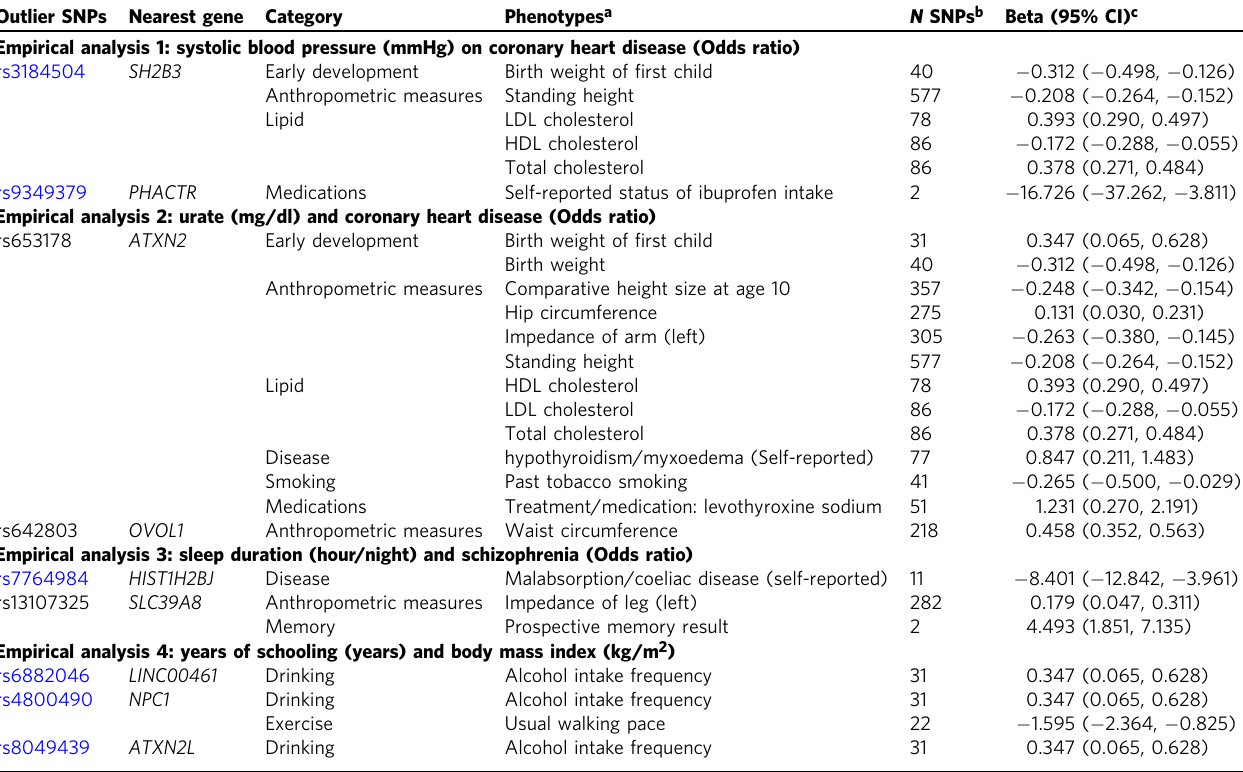
Table 1 Candidate traits associated with both exposure and outcome. Outlier SNPs Nearest gene Category